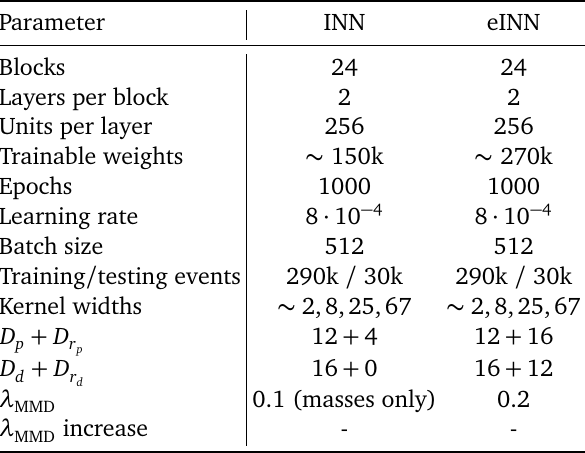
Table 1: INN and noise-extended eINN setup and hyper-parameters, as implemented in P Y T ORCH (v1.2.0) [ 68 ]